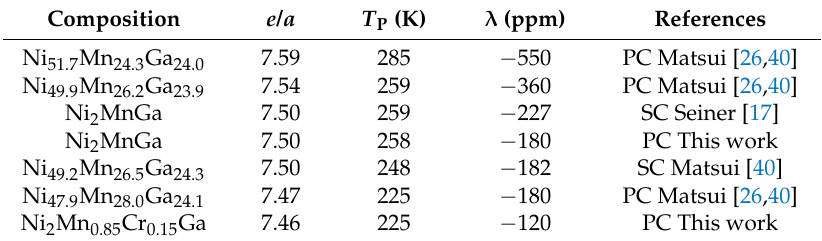
Table 1. The valence electron e / a , the premartensite temperature T P , and peak value of the magnetostriction around the T P for each composition. PC: polycrystal; SC: single crystal. Composition e / a T P (K) λ